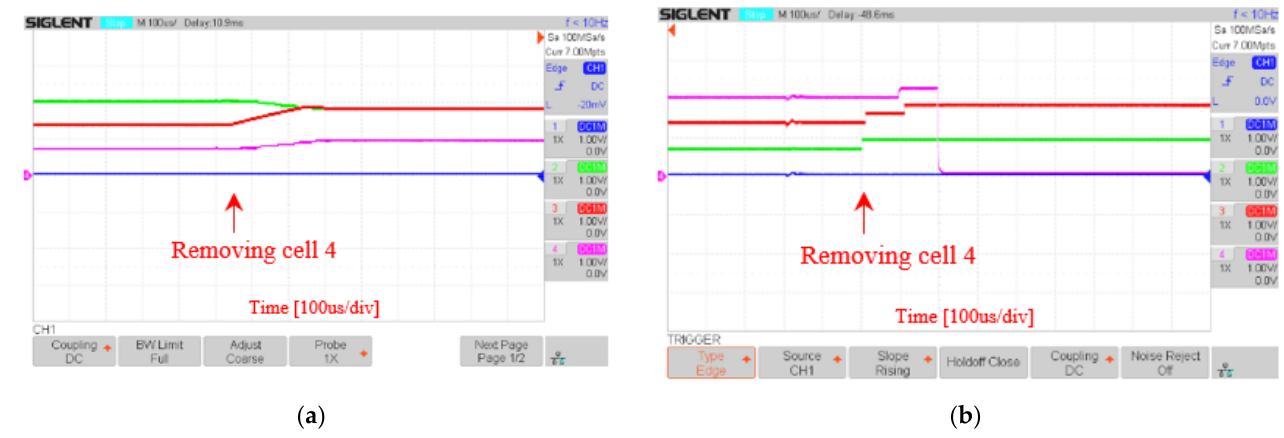
Figure 47. Reconfiguration system response when removing cell 4, ( a ) conventional method; ( b ) proposed DSA-PSC method.